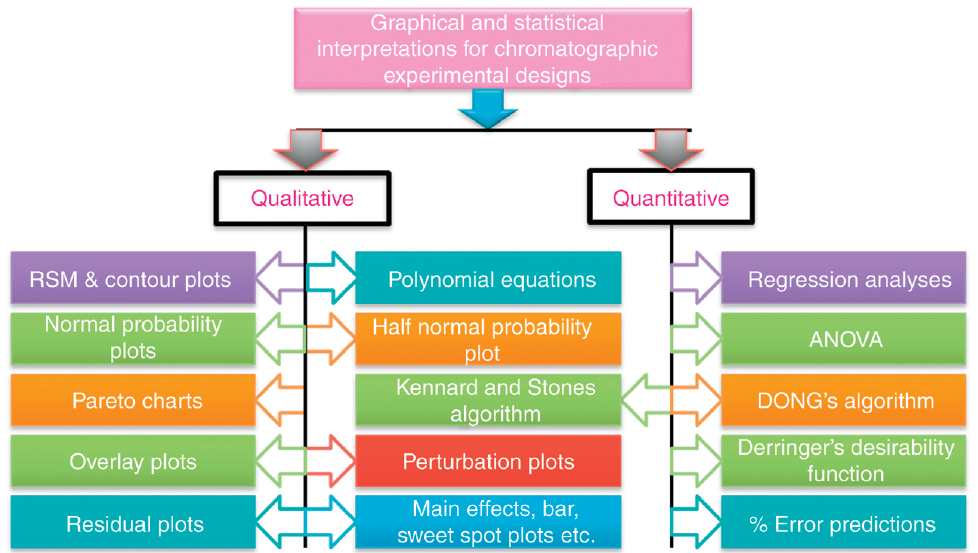
Figure 5: Ways of statistical analyses and interpretations applied in the literature for chromatographic experimental